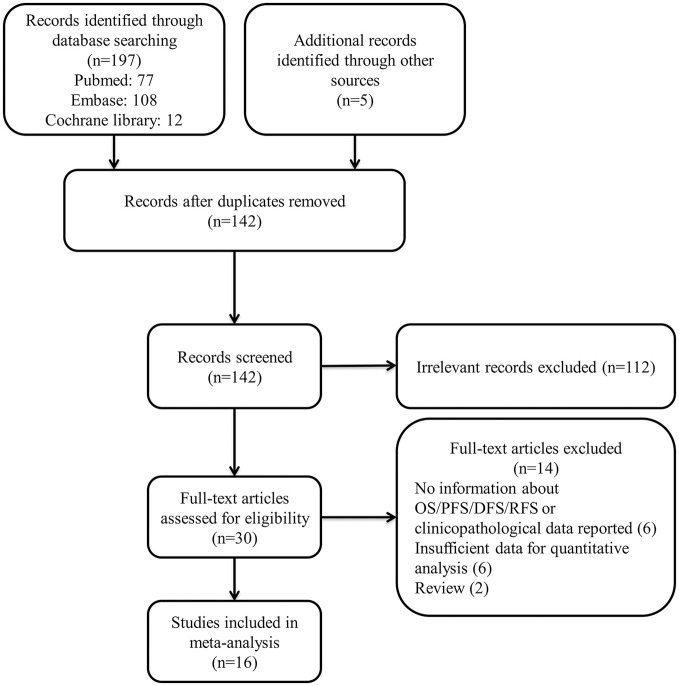
Flow chart of the study screening process.